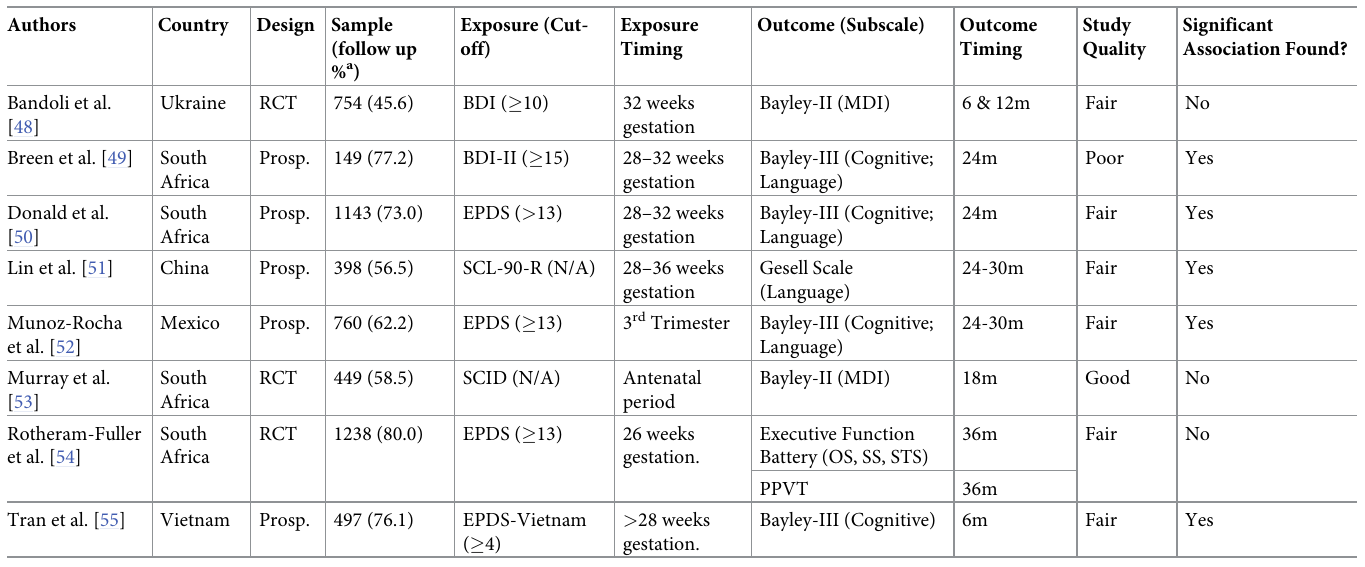
Table 1. Key features of included antenatal studies.